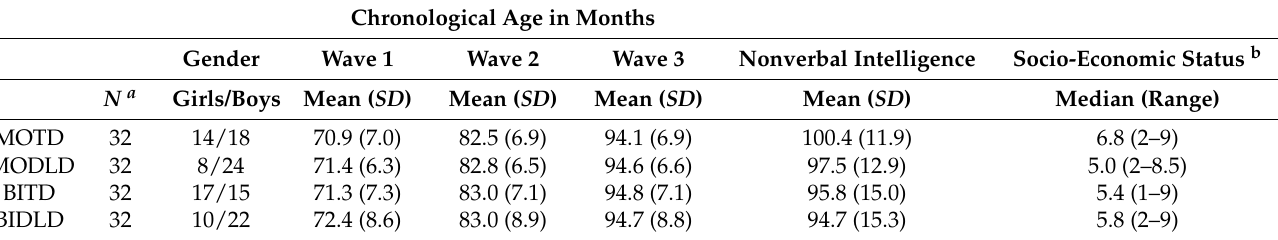
Table 1. Background characteristics of the four groups of